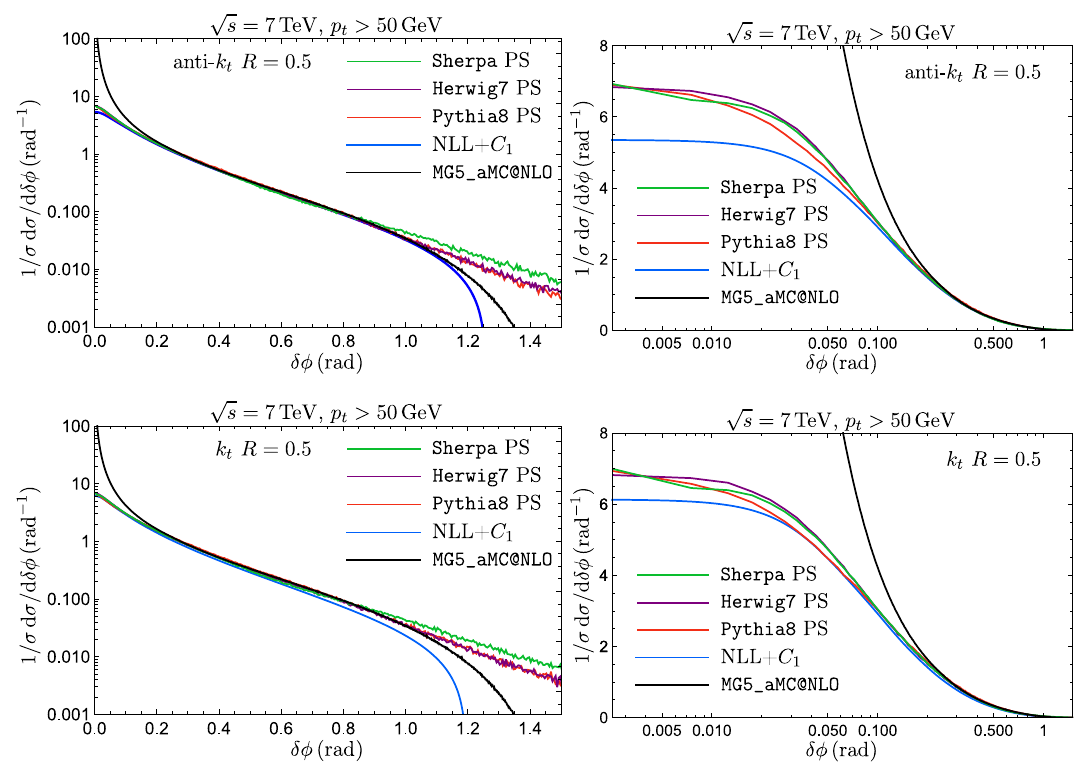
Figure 7 . The differential distributions 1 /σ d σ/ d δφ with anti- k t clustering (top) and k t clustering (bottom). Results are shown for the resummed distribution NLL+ C obtained with various MC event generators. Also shown is the fixed-order NLO MC